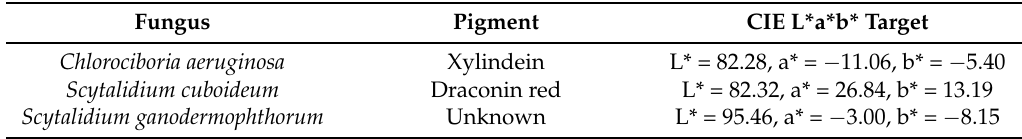
Table 2. Target color readings for fungal pigment